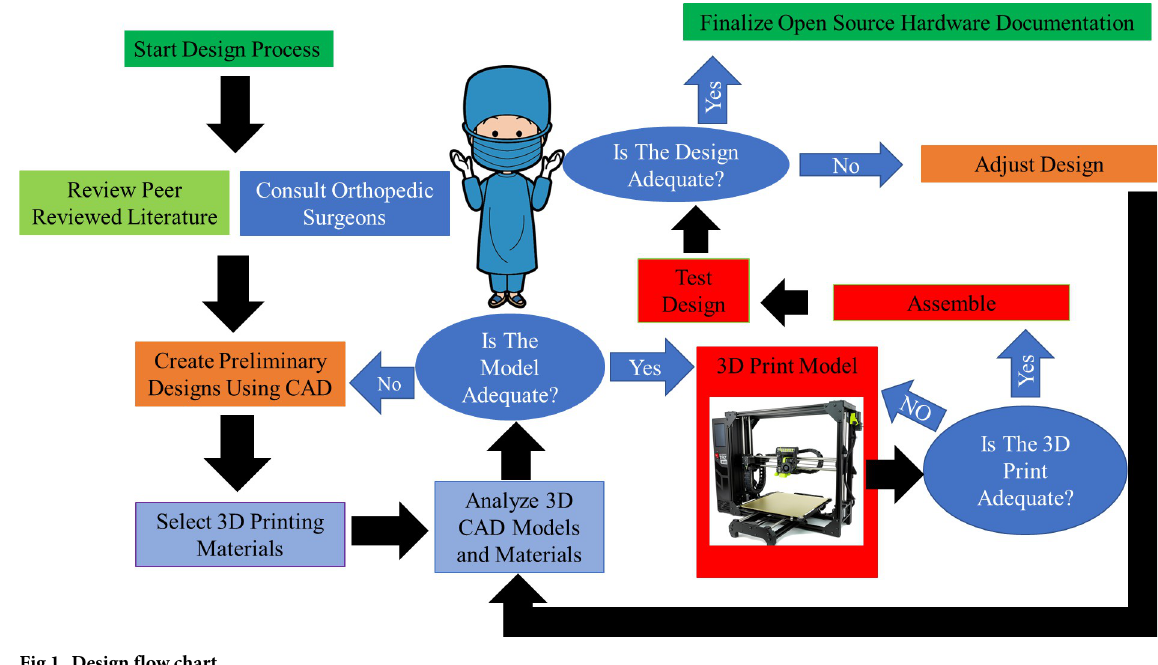
Fig 1. Design flow